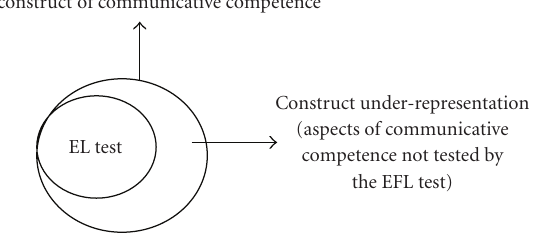
Figure 1: One of the factors a ff ecting test construct